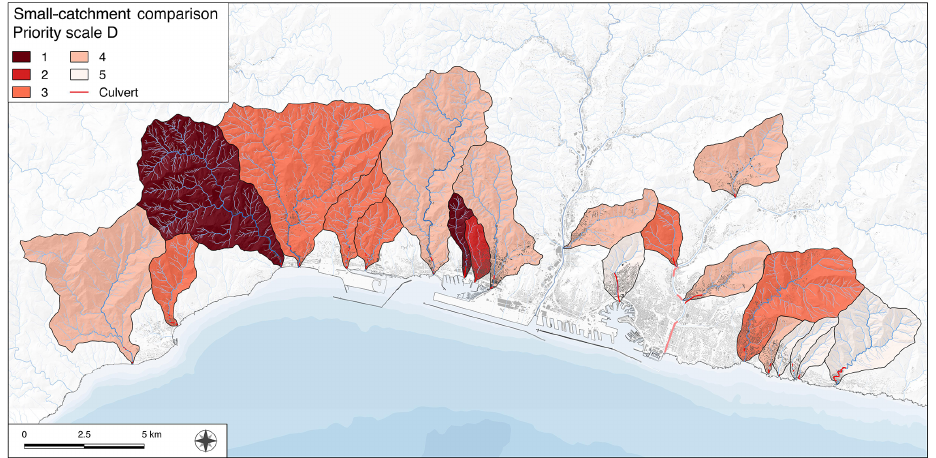
Figure 9. The priority scale obtained using all the parameters, excluding DSGSD for the calculation of landslides and weighting the elements of risk factors.